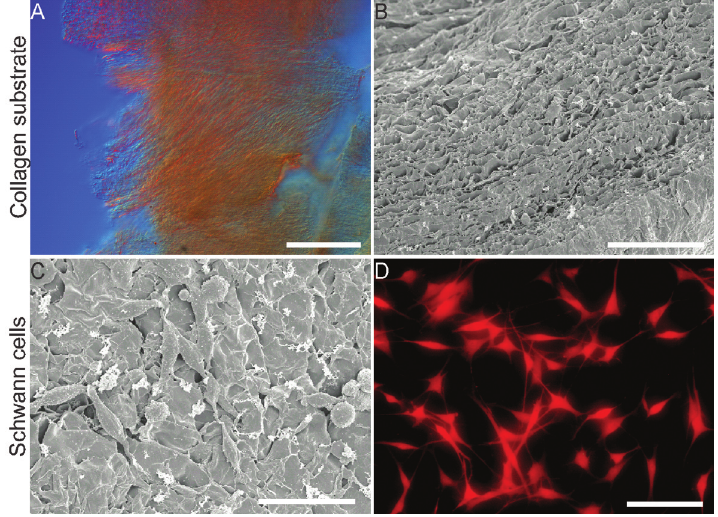
Figure 1. A, Representative samples of supraorganized collagen depicting the parallel arrangement of the fibrils (bar = 100 µm). B, Collagen substrate observed by scanning electron microscopy. Note the multilayer organization as well as the porosity of the material (bar = 100 µm). C, Schwann cells cultured on the collagen substrate. Observe the adhesion shown by the cell projections over the surface of the material (bar = 50 µm). D, Representative example of a purified Schwann cell culture immunolabeled against S-100 (bar = 10